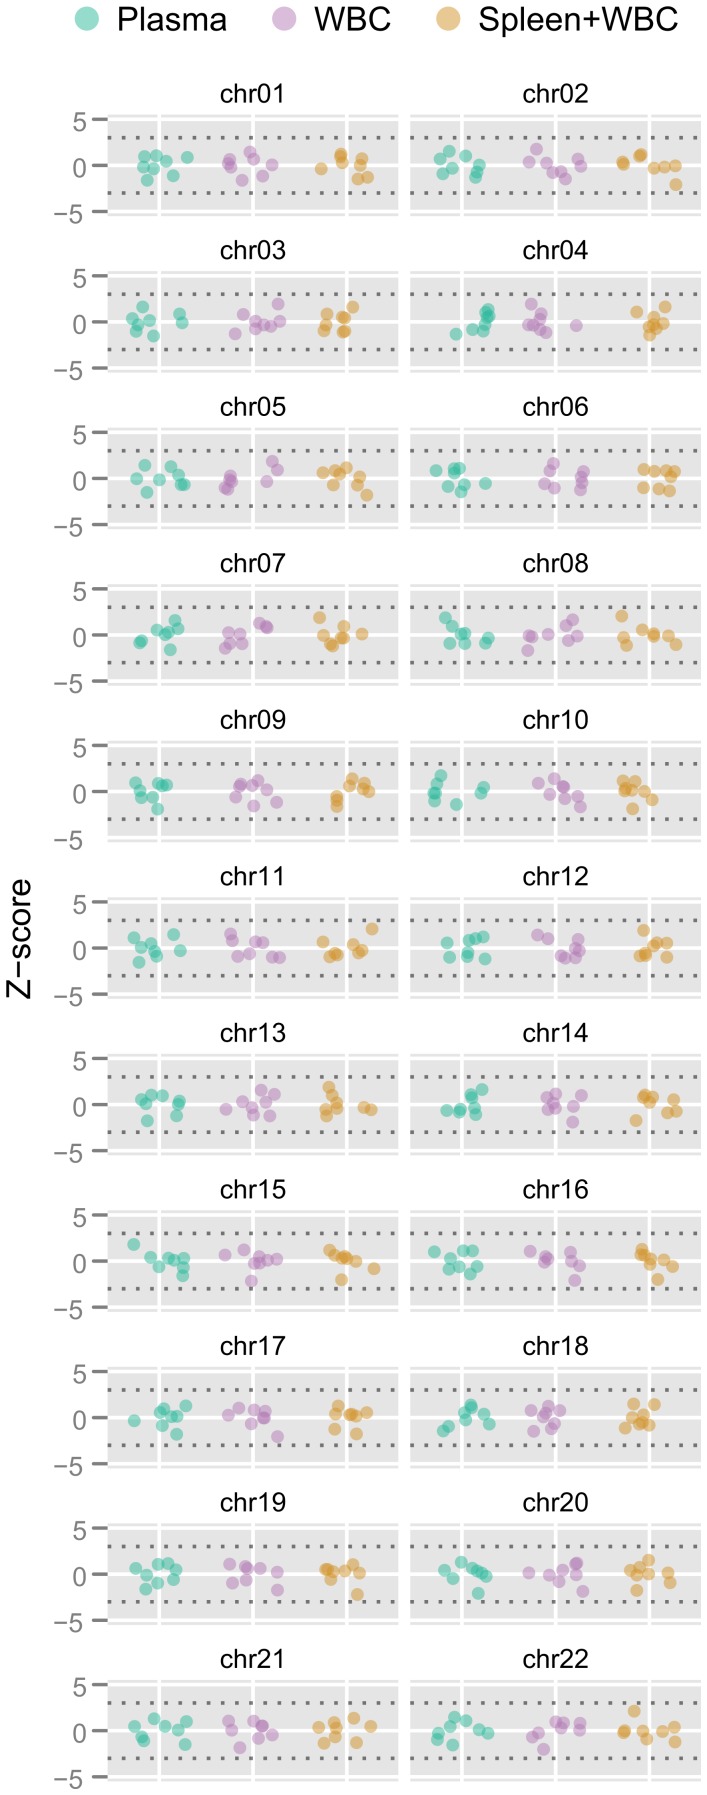
Demonstration of FAST-SeqS reproducibility among different samples, sequencing instruments, and sequencing depth.FAST-SeqS was performed on eight normal plasma DNA samples, their corresponding matched peripheral blood white blood cell (WBC) DNA, and on the splenic or WBC DNA of an additional eight unrelated individuals. The eight samples within each experiment constituted the reference group (see ‘Materials and Methods’ section) from which the plotted z-scores were calculated. No autosome in any sample had a z-score outside the range of −3.0 and 3.0 (dotted lines). Despite 3-fold less sequencing of the splenic or WBC samples, the z-scores (range: −2.2 to 2.1) were similar to those obtained from the plasma (range: −2.1 to 1.9) and matched WBC DNA samples (range: −2.2 to 1.9).